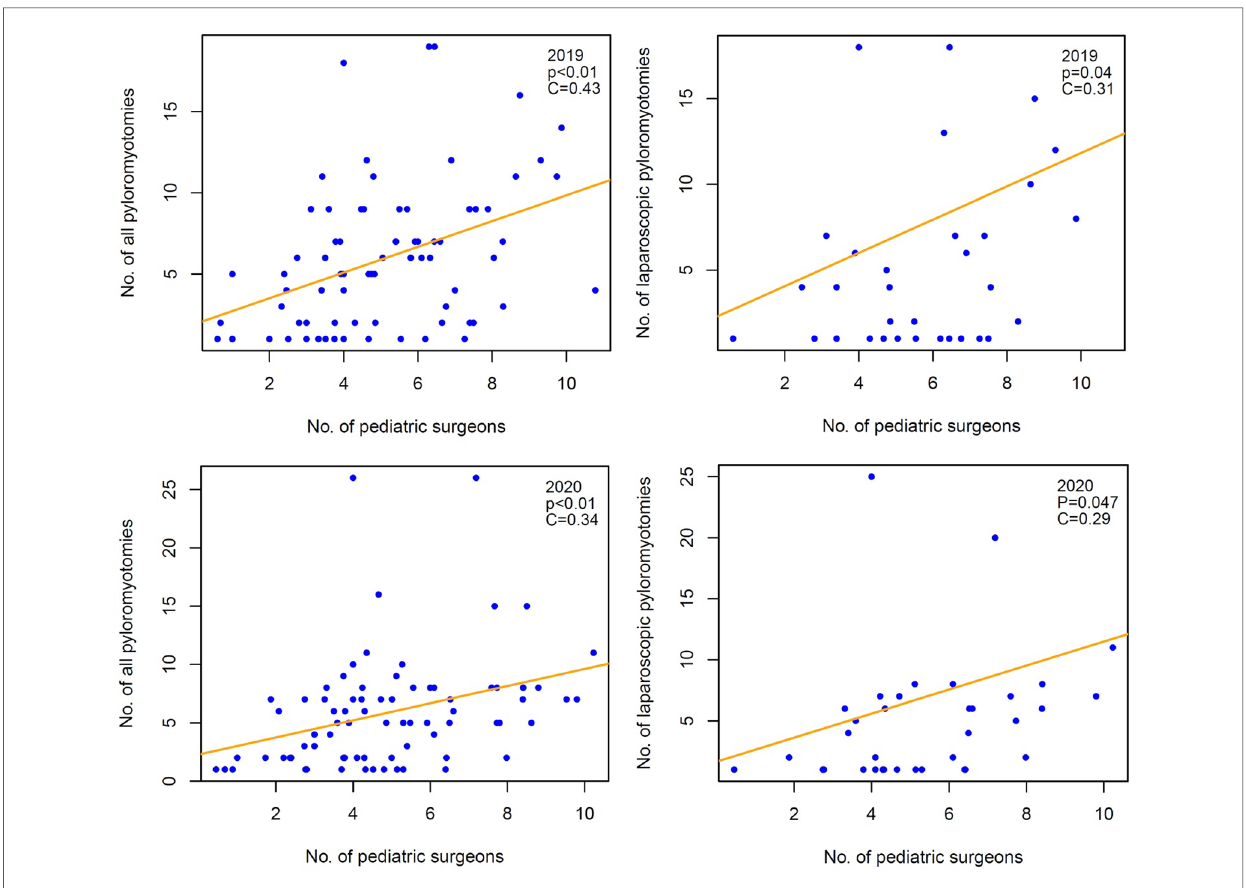
FIGURE 3 Weak correlation between number of all and laparoscopic pyloromyotomies and number of pediatric surgeons.